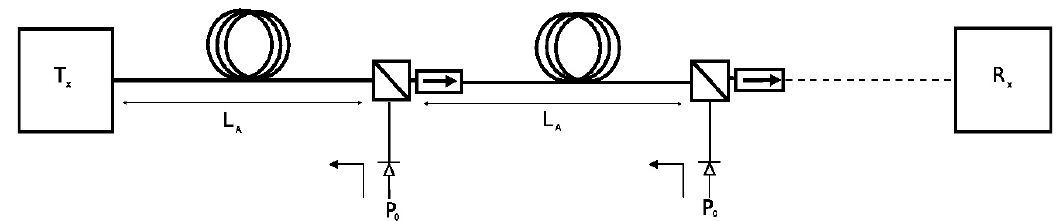
Figure 2. Scheme for a Raman amplification system in counter-propagation. L A accounts for the distance between pump